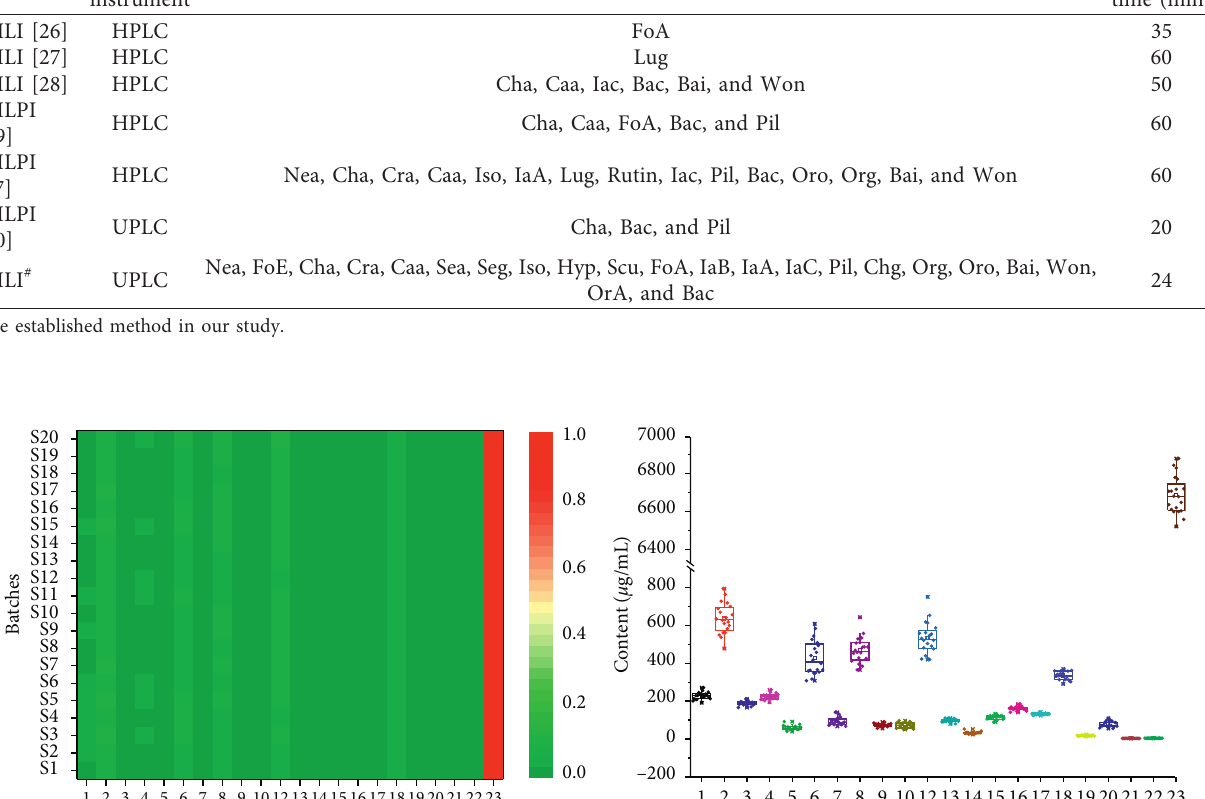
Table 3: Comparation between the previously reported analytical methods and our established method. Drugs